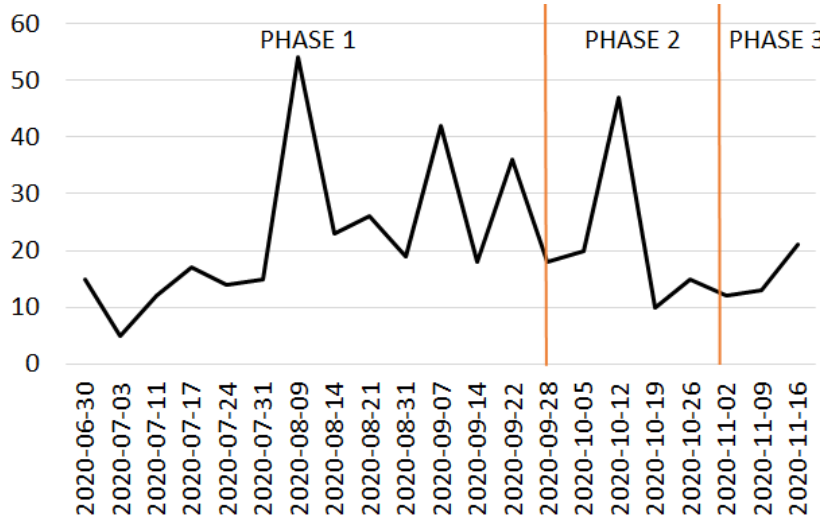
Figure 13. Studied timeline of tweets during COVID-19 pandemic.